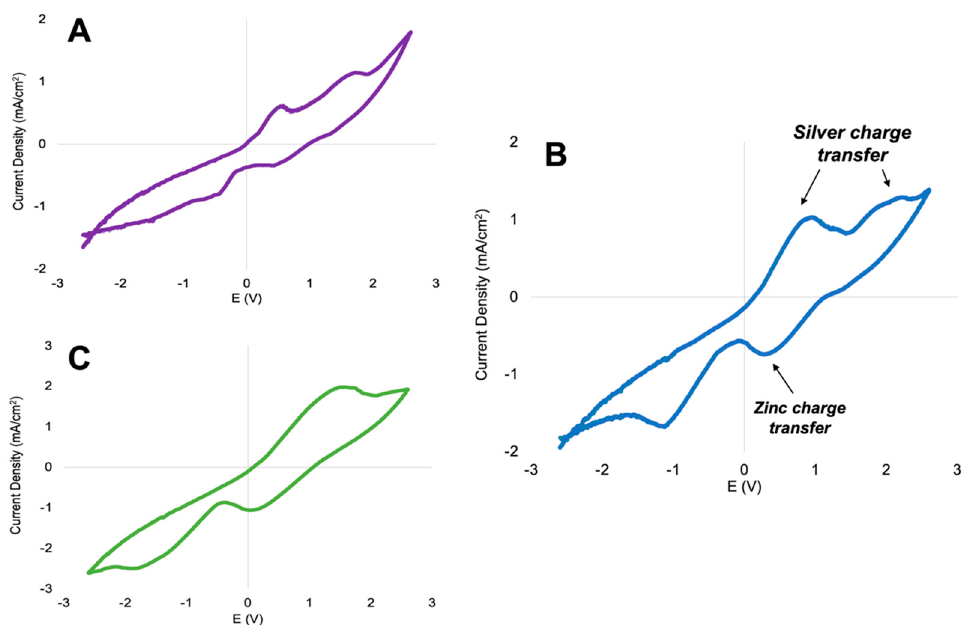
Figure 3. Cyclic voltammetry of the Ag/AgCl-Zn cell at scan rates of ( A ) 30 mV/s, ( B ) 160 mV/s, ( C ) 320 mV/s. The potential was swept from − 2.6 V to +2.6 V, then reversed.